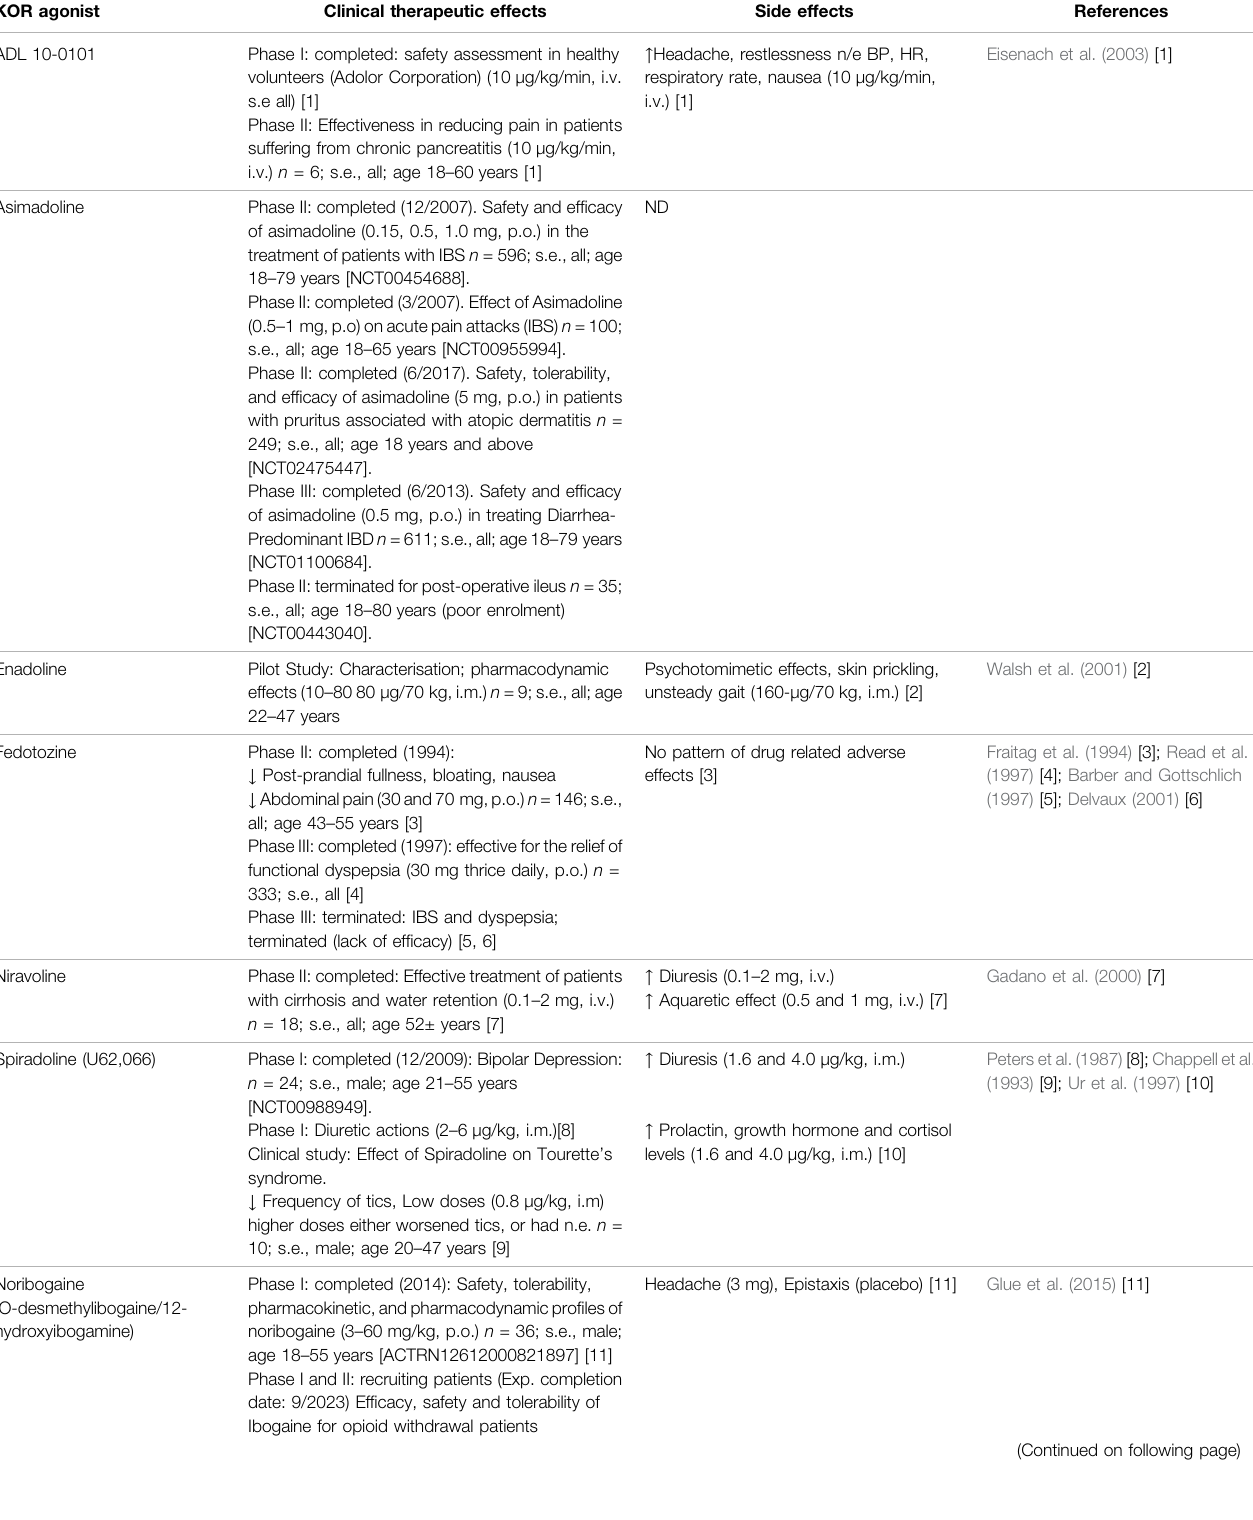
TABLE 2 | Therapeutic effects and side effects of KOR agonists in clinical studies. KOR